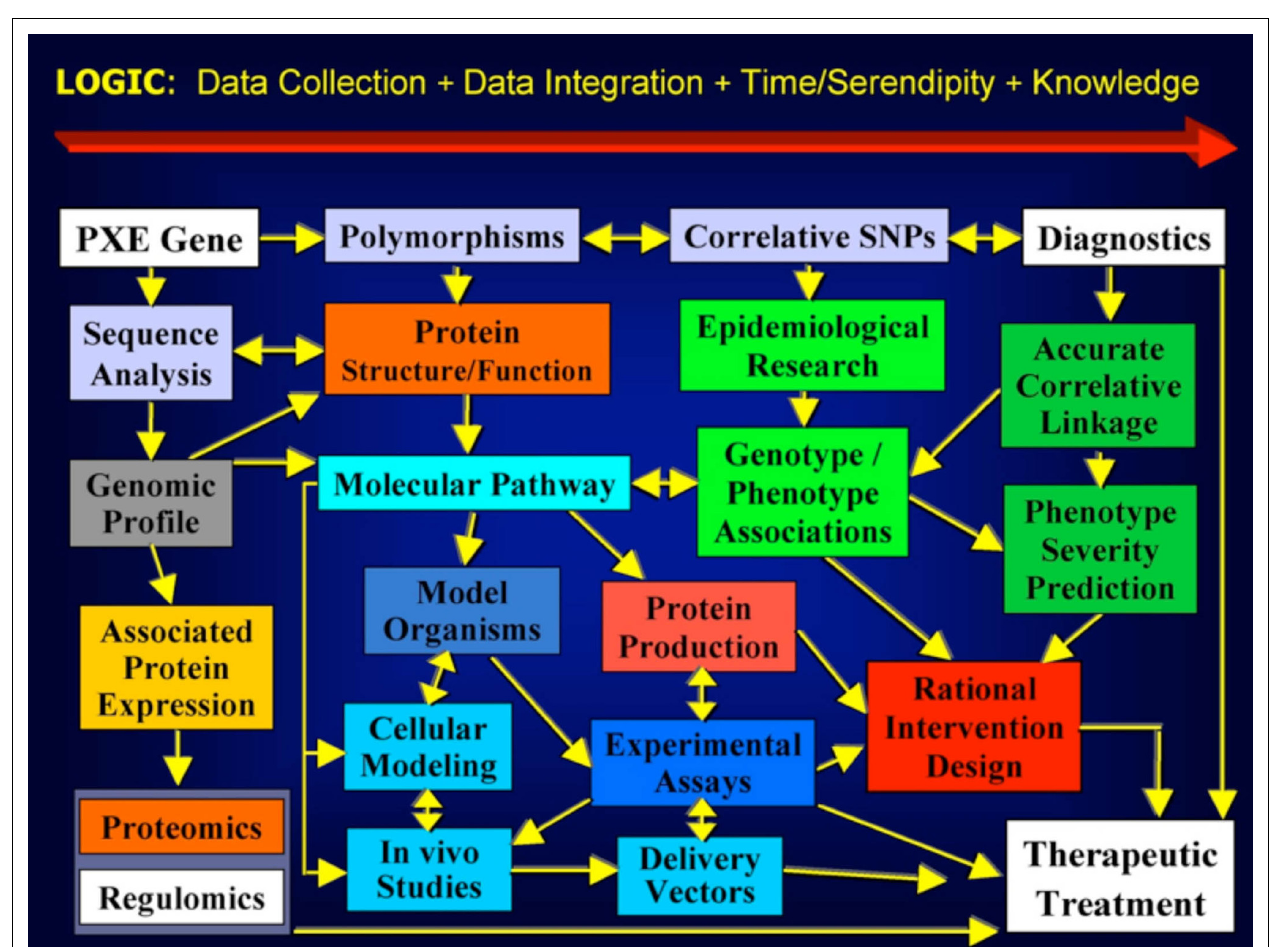
FIGURE 1 | PXE International’s 1995 Strategic Plan (published inTerry and Boyd,